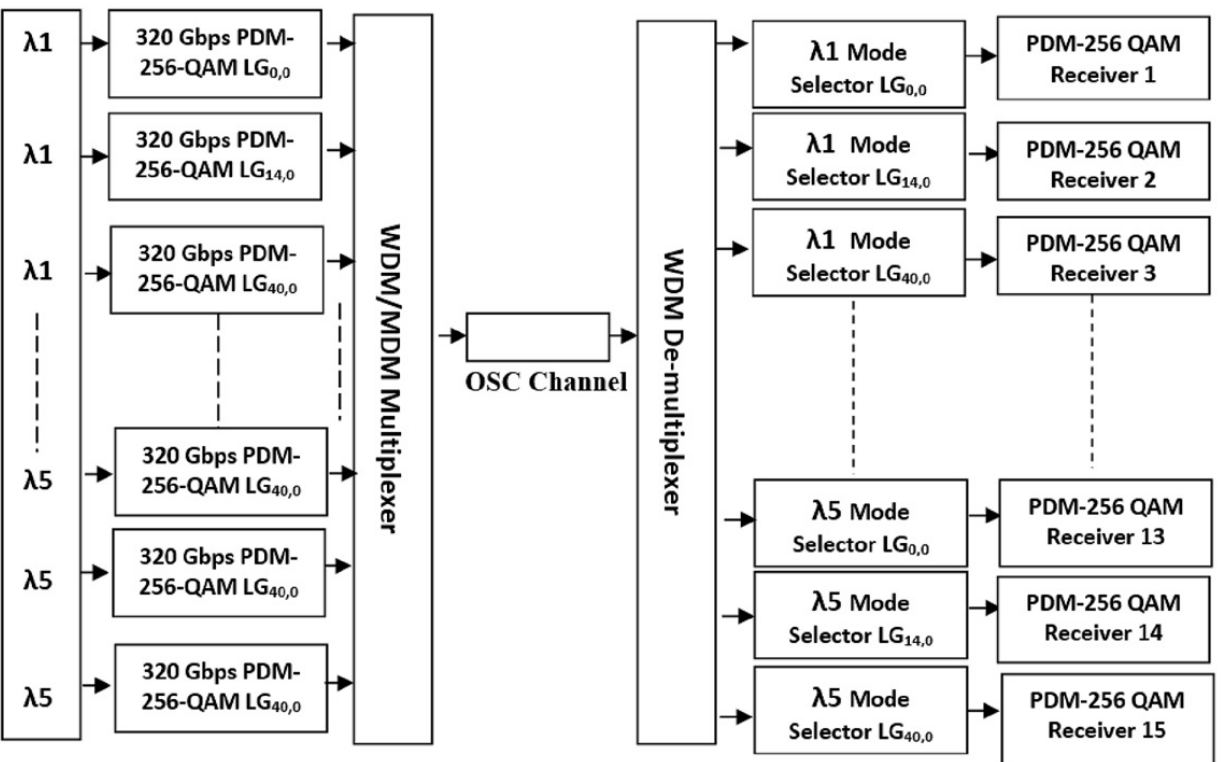
Figure 3. System setup of proposed 320 Gbps × 5 λ × 3 OAM modes based OSC system.